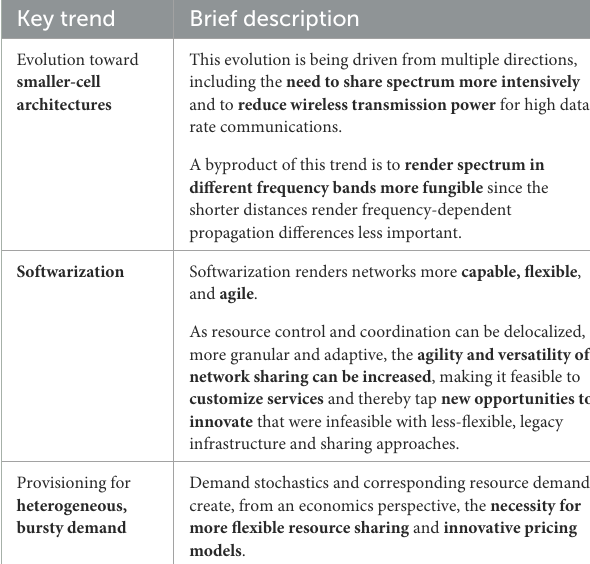
TABLE 1 Key trends that facilitate or drive more dynamic sharing